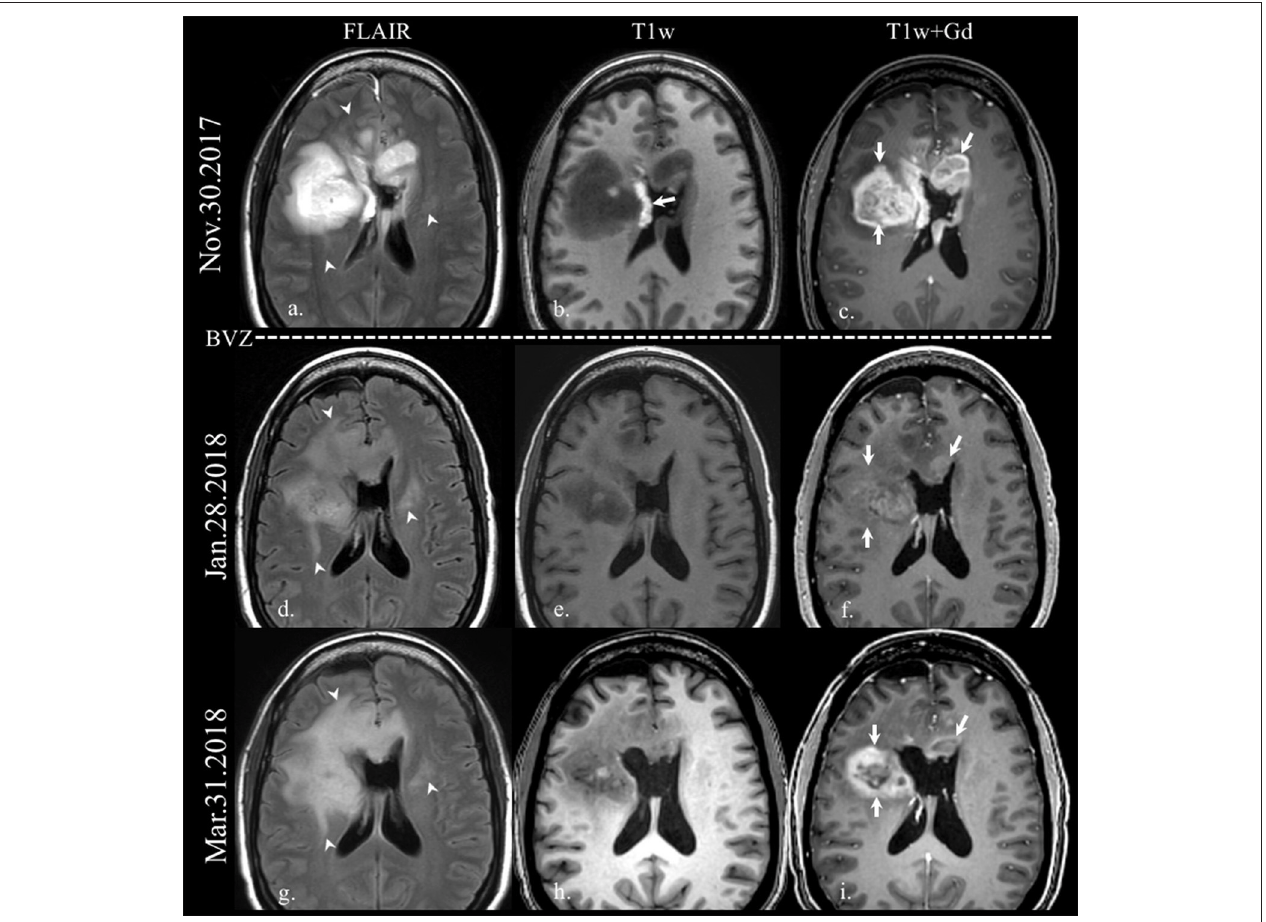
FIGURE 1 | Enhancement in pseudoresponse. Brain MRI of a old patient with a GBM (IDH wild-type, MGMT status unknown) on the first recurrence after standard-of-care treatment. Axial FLAIR (a,d,g) , and axial T1w before (b,e,h) and after gadolinium administration (c,f,i) images are displayed. On the top row, the immediate postoperative scan after the second resection demonstrates residual enhancing tumor on the right frontal lobe and on the left aspect of the genu of the corpus callosum (arrows on c ). The arrow on b points some post-surgical blood products on the lateral wall of the right lateral ventricle. Note how the FLAIR hyperintensity extension increases on follow-up scans (arrowheads on a,d,g ) after the onset of treatment with bevacizumab (BEV), while the enhancing area decreases dramatically (arrows on f ), with reappearance despite antiangiogenic treatment (arrows on i